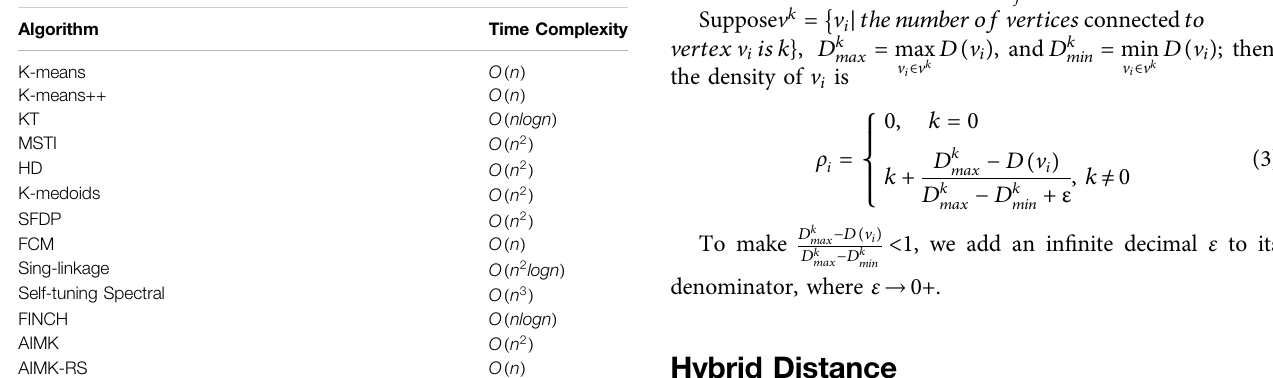
TABLE 1 | Comparison of Time complexity.